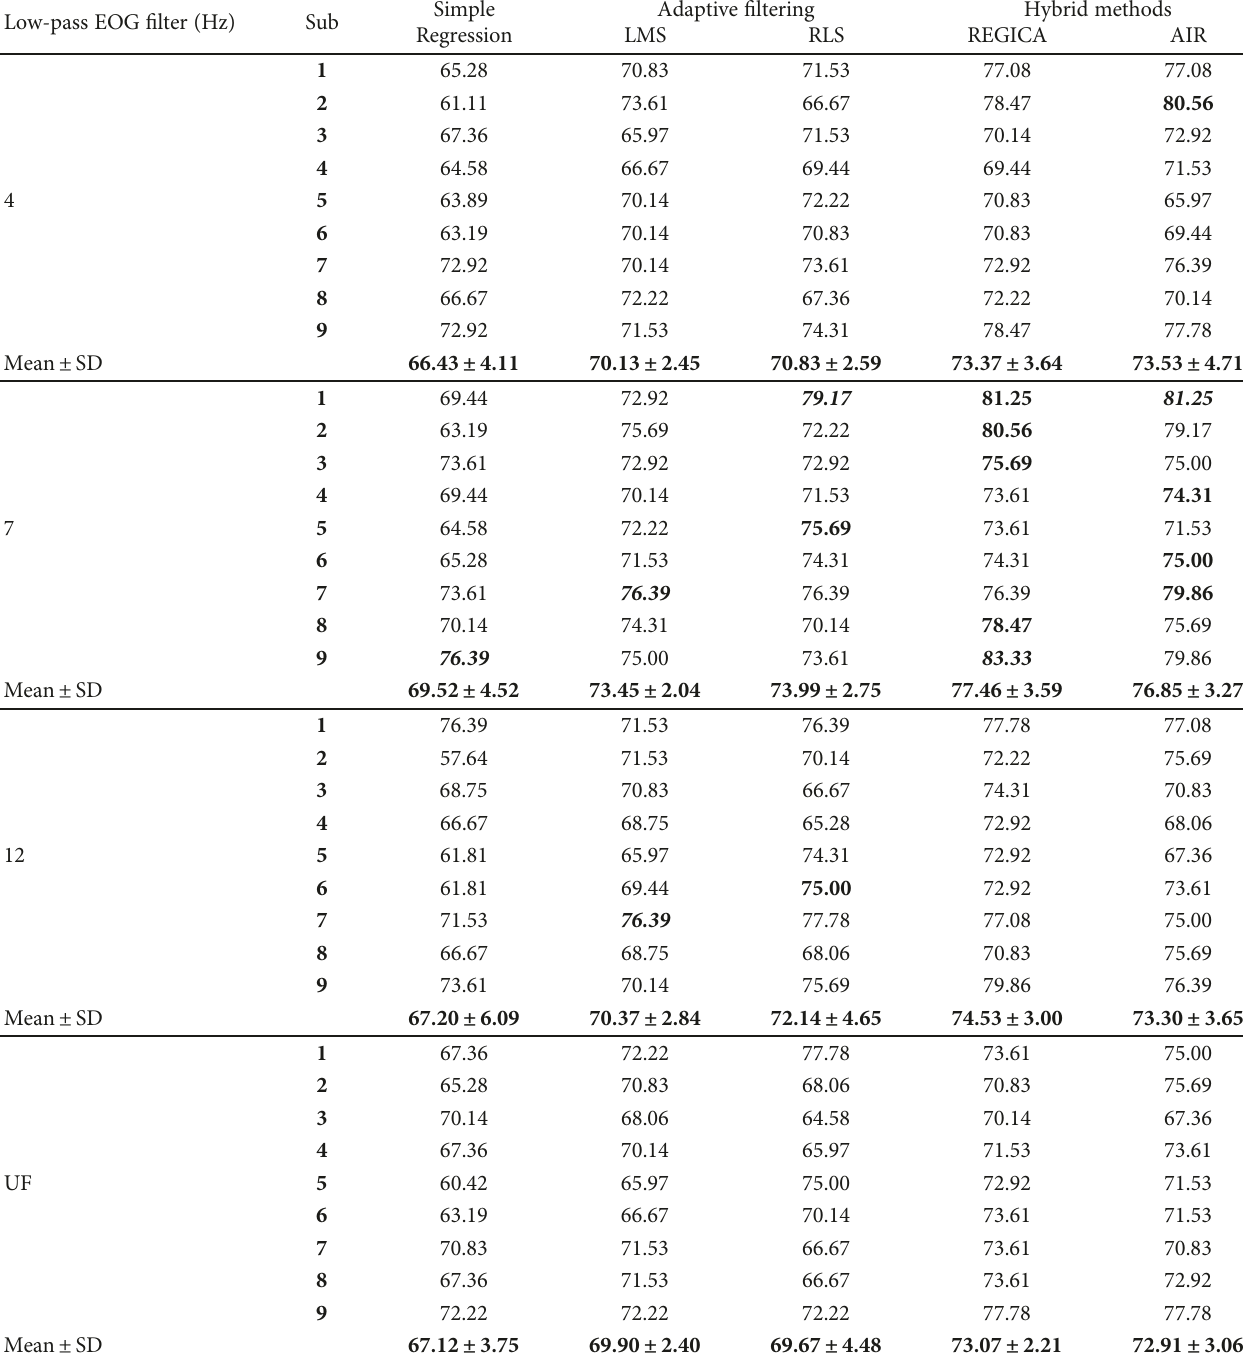
Table 11: Classi fi cation accuracies (mean of all six runs for each subject). Simple Adaptive fi ltering Low-pass EOG fi lter (Hz) Sub